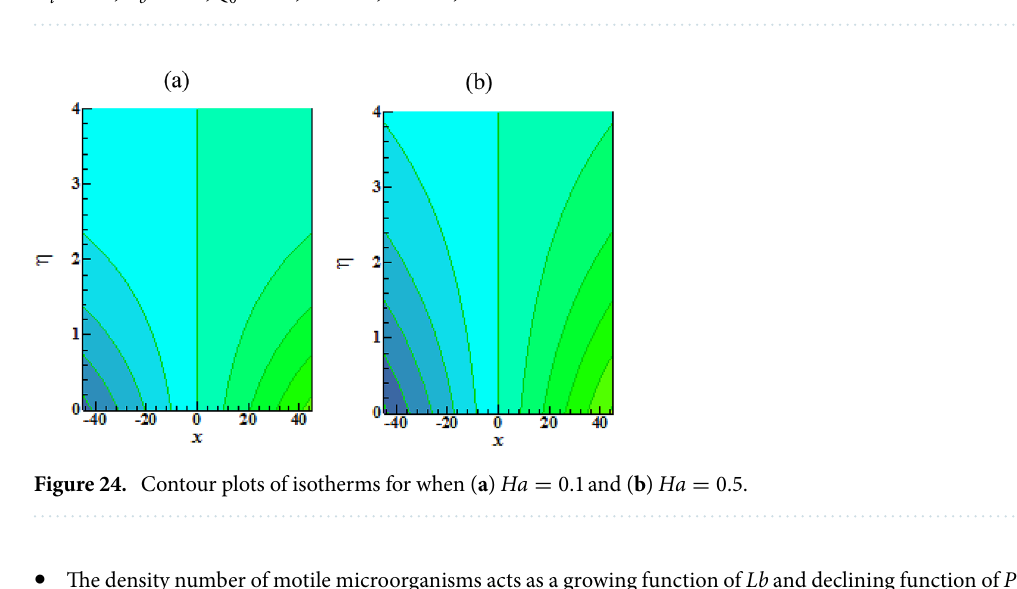
0.4, R 0.2, (cid:31) 0.1, N 0.1, M 0.2, 0.2, Pe r = b = = = = =